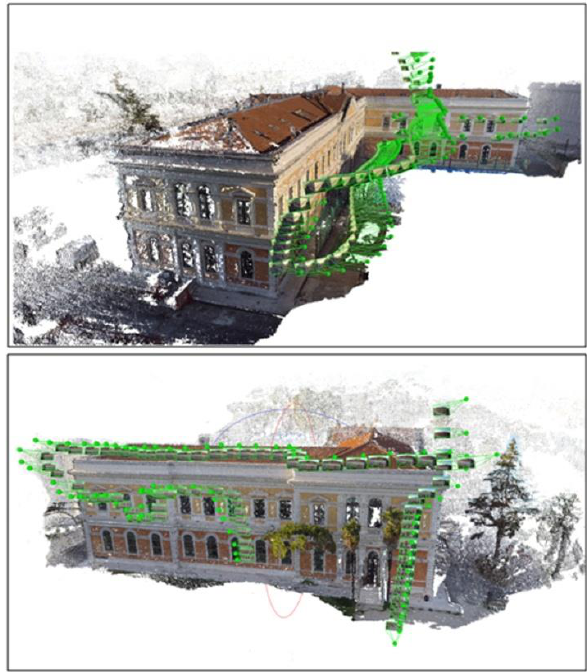
Figure 2 Point clouds from drone elaborated with the Pix4d